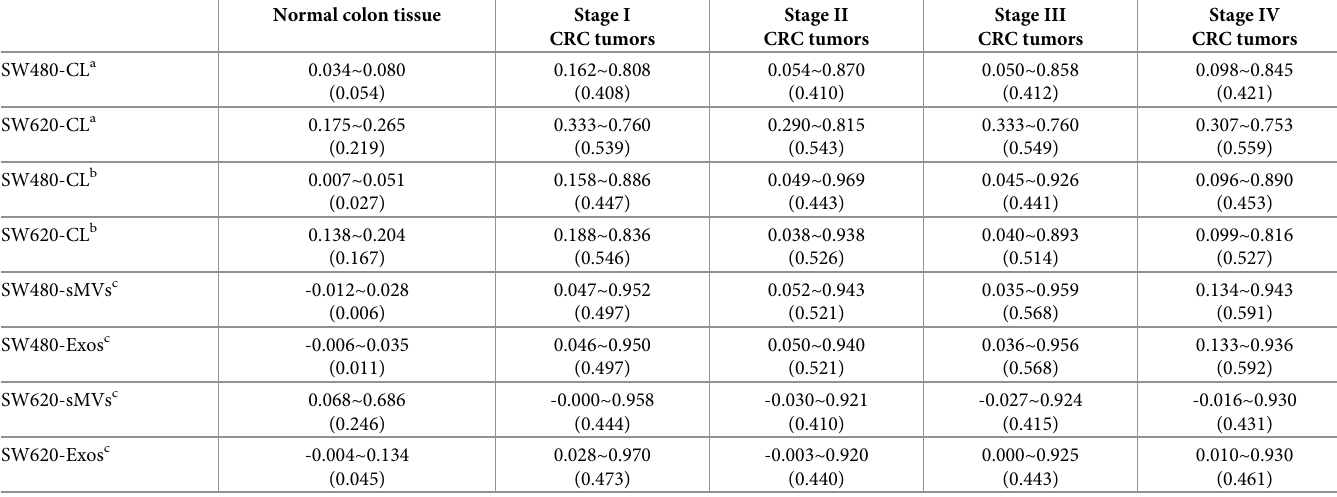
Table 2. Correlation of SW480/SW620 miRNA profiles with normal colon tissue and CRC tumors of different pathological stages. Normal colon